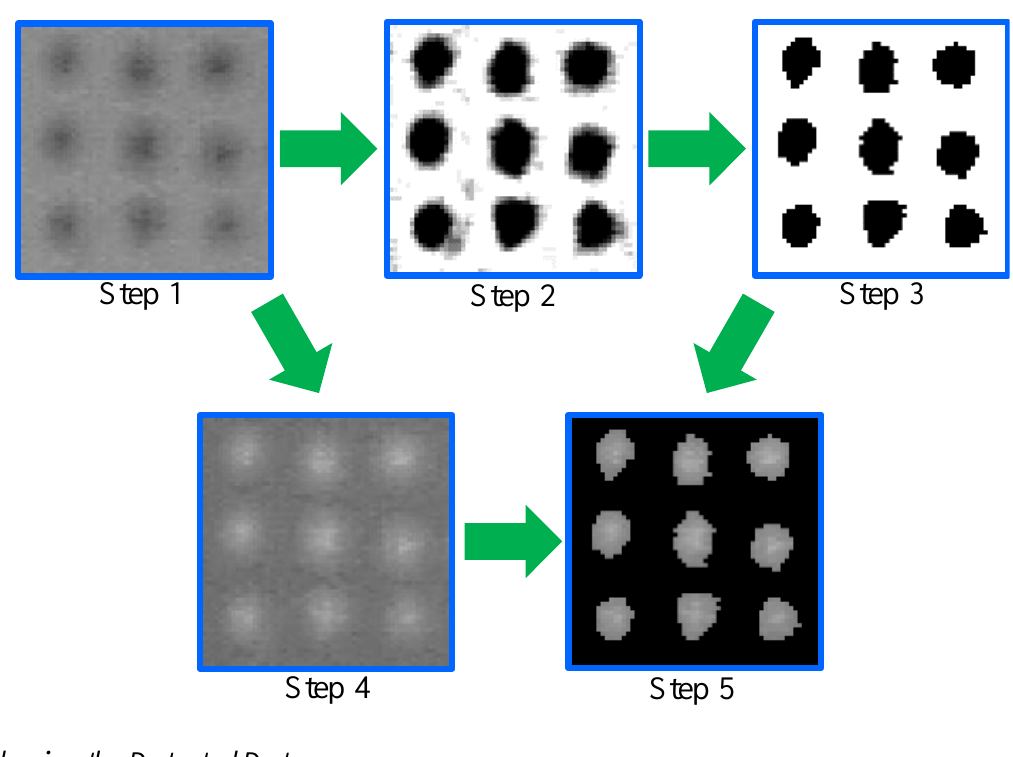
Figure 5. Image processing to detect the dots in captured